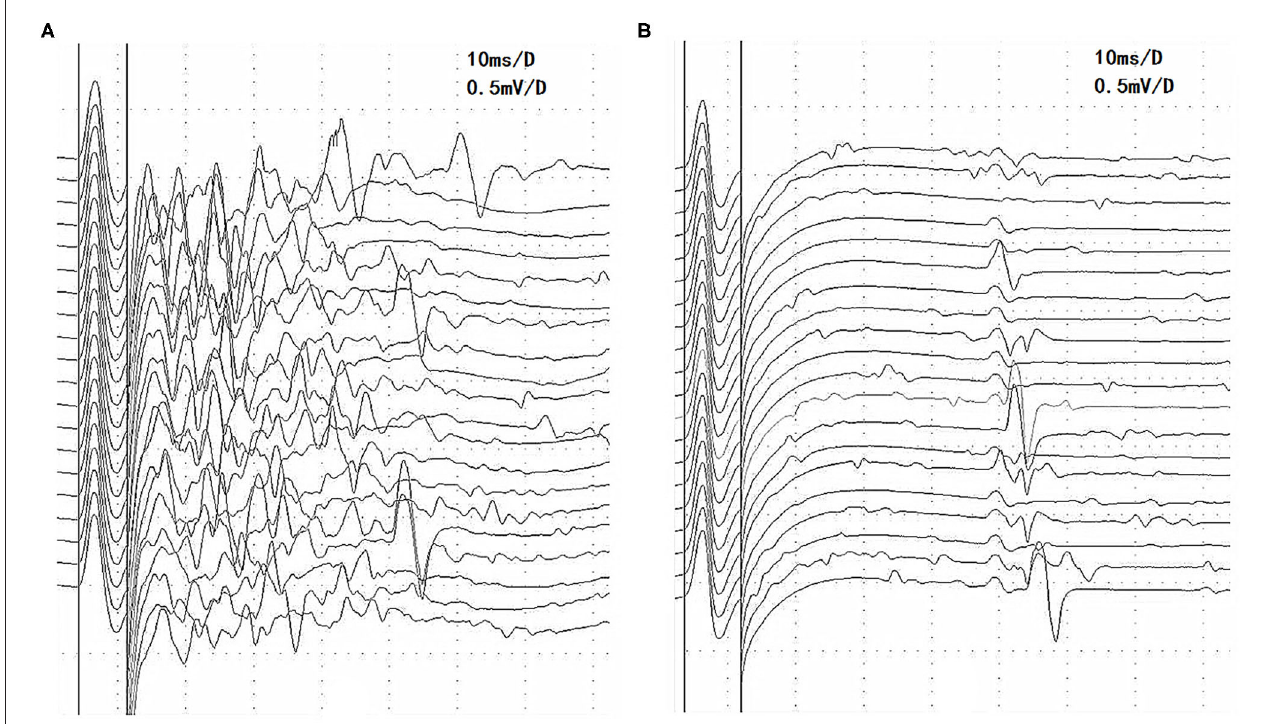
FIGURE 1 | Changes in afterdischarges on the F-wave recording of the tibial nerve before and after pyridostigmine bromide discontinuation in patient 1 with MuSK-MG. (A) Afterdischarges appeared before pyridostigmine bromide discontinuation. (B) Afterdischarges disappeared after pyridostigmine bromide discontinuation, and the F waves are seen clearly. MuSK-MG, muscle-specific tyrosine kinase antibody-positive myasthenia gravis.